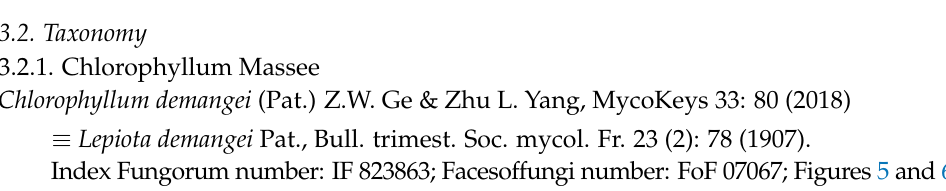
Figure 5. Fresh basidiomata of Chlorophyllum demangei in situ. ( a , b ) MFLU 09-0005. ( c ) MFLU 12-1769.